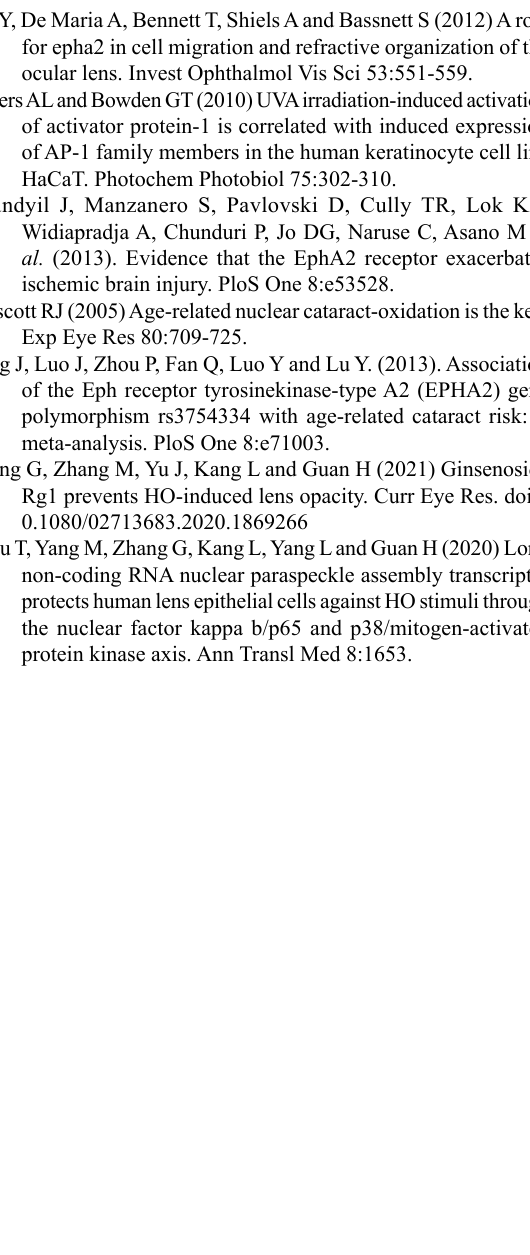
Figure S1 – EphA2 overexpression enhanced Cleaved- caspase-3 expression in H Figure S2 – The mechanism of action of EphA2 in